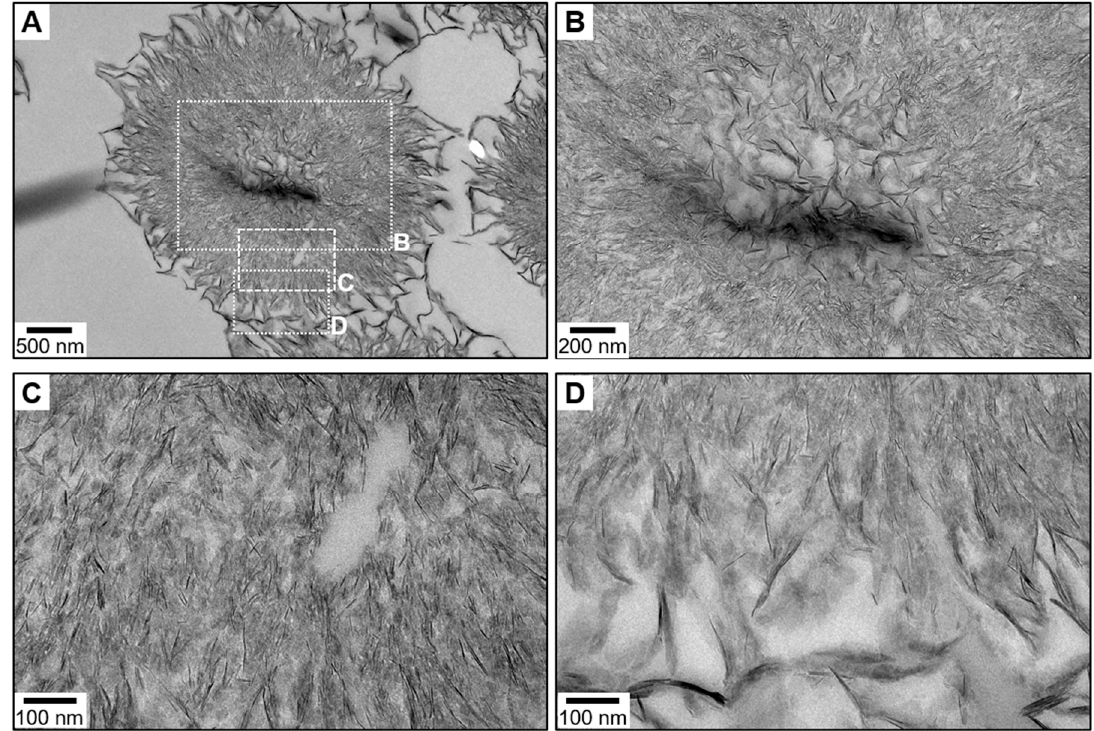
Figure 5. Orientation of the bone-like hydroxyapatite particles following their growth process. Shown are transmission electron micrographs (TEM) of a microtomed cross-section of Carbonated HydroxyApatite (CHA) spherulites. The region in ( A ) is a single spherulite that was approximately cut in half; ( B ) shows the core of the spherulite; ( C ) shows the zone next to the core shown in ( B ); while ( D ) shows the outer layer of the spherulite.